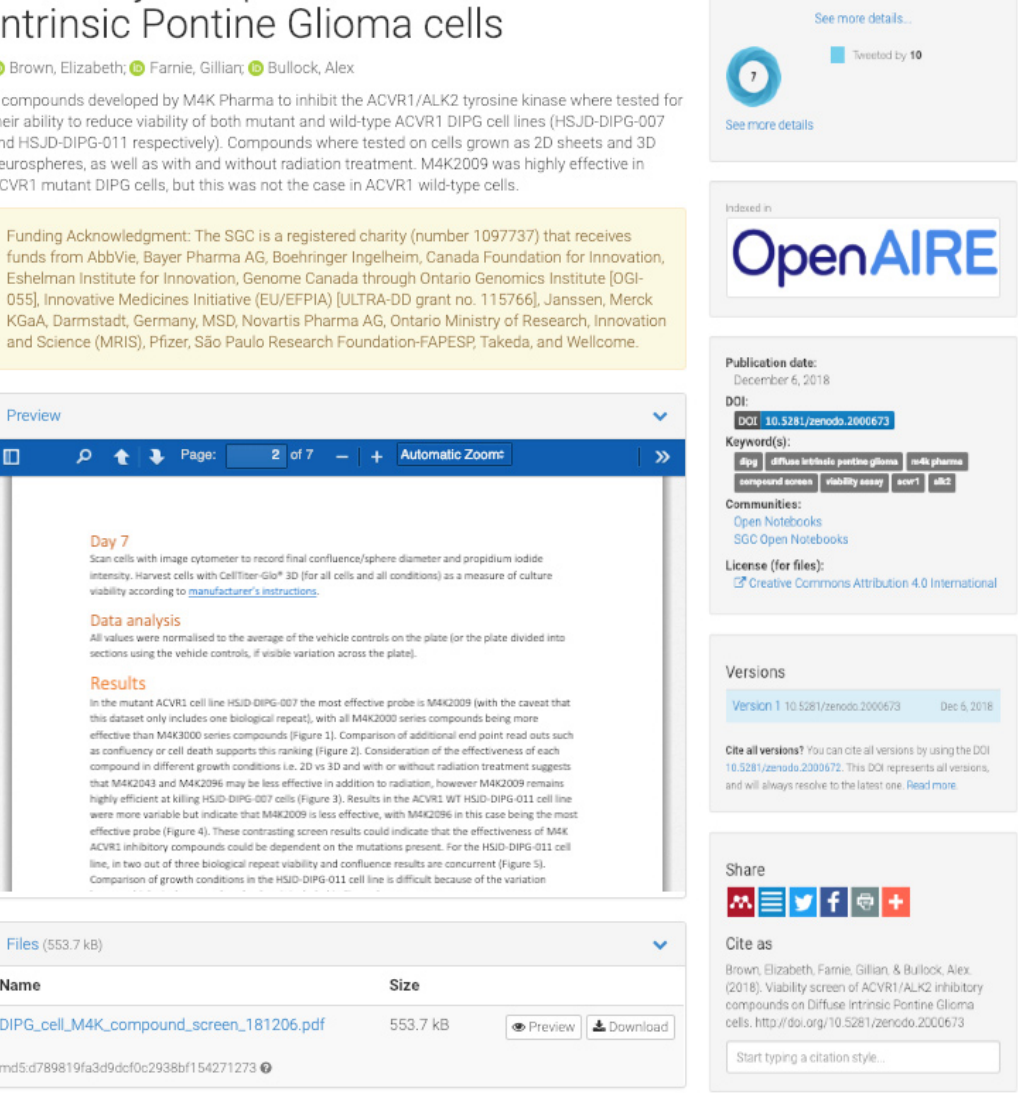
Figure 1. Detailed experimental records including protocols, positive and negative data are posted on Zenodo. A citable DOI is automatically generated (right-middle panel), and the number of visits and downloads provided (top right, numbers as of December